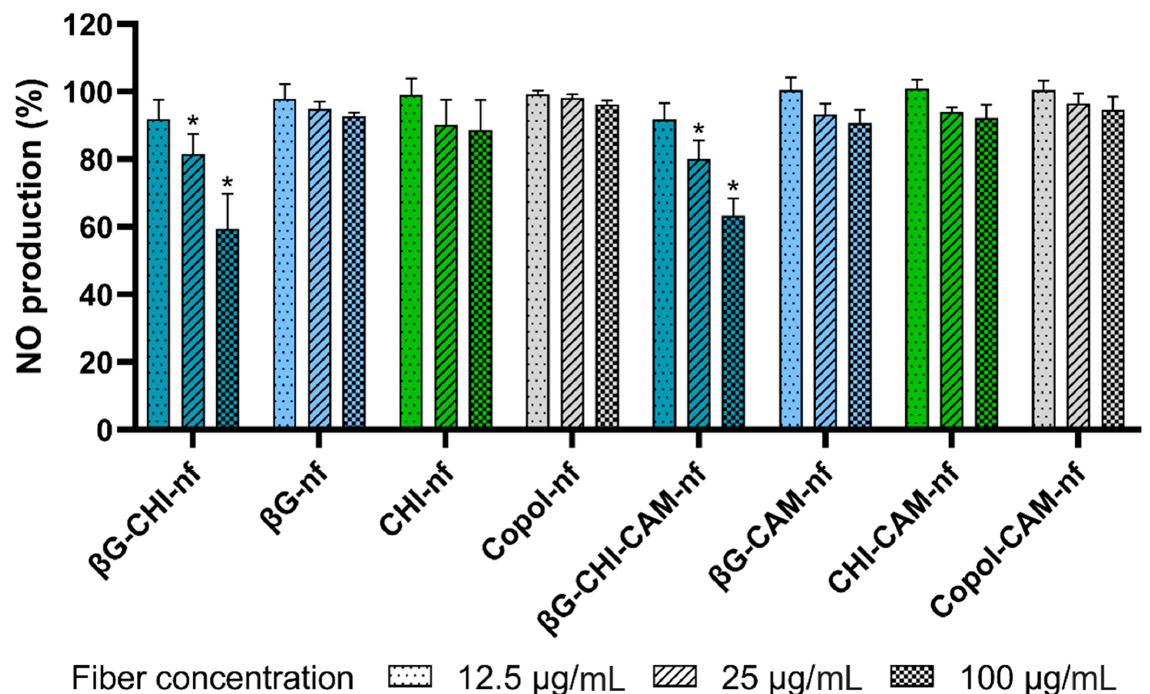
Figure 5. NO production (%) of LPS-induced macrophages (RAW 264.7 cells) after 24 h exposure to nanofibers in three different concentrations (12.5, 25 and 100 µg/mL) compared to untreated cells. Abbreviations: β G ( β -glucan), CHI (chitosan), Copol (co-polymers: polyethylene oxide and hydroxypropylmethylcellulose), CAM (chloramphenicol), nf (nanofiber). Results are presented as mean ± SD ( n = 3). Formulations marked with * are statistically significant ( p < 0.05) compared to untreated LPS-stimulated macrophages.